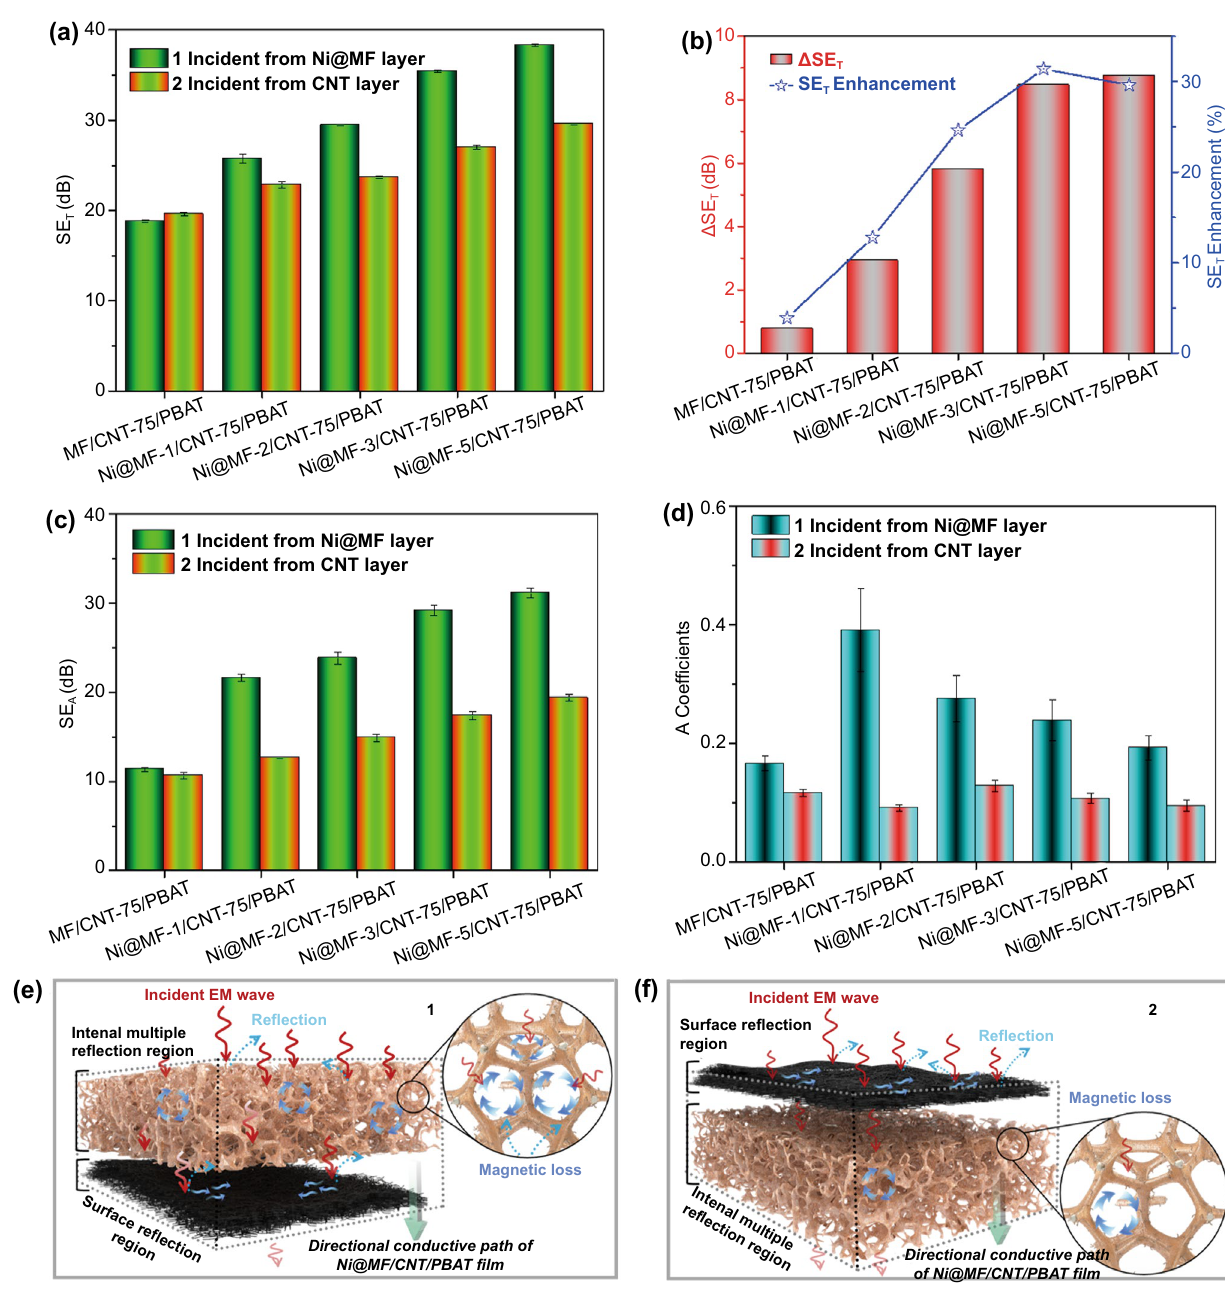
Fig. 4 Directional EMI shielding mechanism. a The average SE T of Ni@MF/CNT-75/PBAT composites with the incident EM wave from dif- ferent sample sides. b ΔSE T and SE T enhancement of Ni@MF/CNT-75/PBAT composites when the EM wave is incident from different sample sides. c The average SE A and d coefficients of Ni@MF/CNT-75/PBAT composites with the incident EM wave from different sample sides. e, f Schematic diagram of the directional EMI shielding mechanism for step-wise asymmetric Ni@MF/CNT-75/PBAT